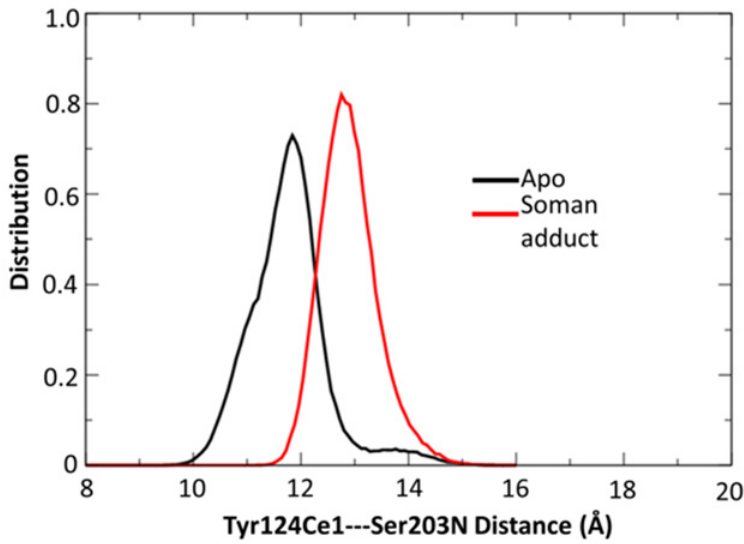
Fig 11. Distance distributions for the Tyr12Ce1 to Ser203N atoms. The soman-adducted structures show a significant increase in distances in comparison to the apo structures. This increase is due to the interactions of the phenol sidechain with the pinacolyl tail. A small peak at 14 Å in the apo distribution suggests a second conformation that allows ligand access to the catalytic triad.